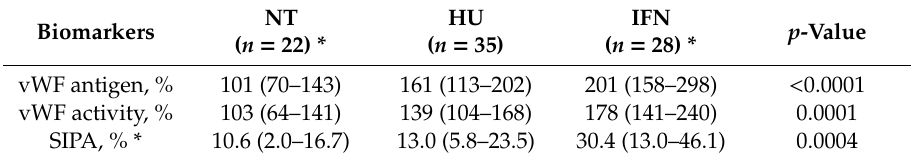
Table 2. Biomarkers of endothelial activation according to cytoreductive treatment group.